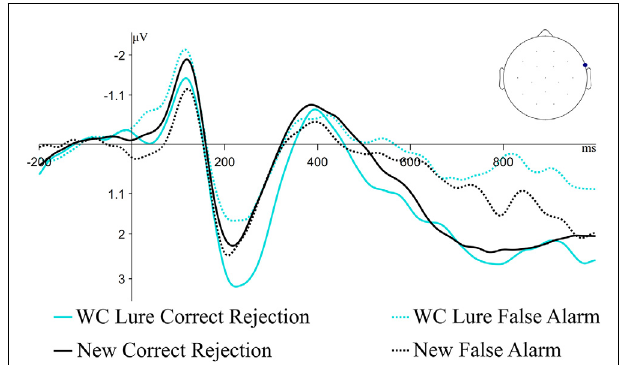
FIGURE 6 | Grand average ERP waveforms for correct rejections and false alarms for Weak Constraint Lures and New items at the previously described maximal channel from the WC Lure cluster analysis. The pattern of responses for New items appears similar to the WC Lure items.